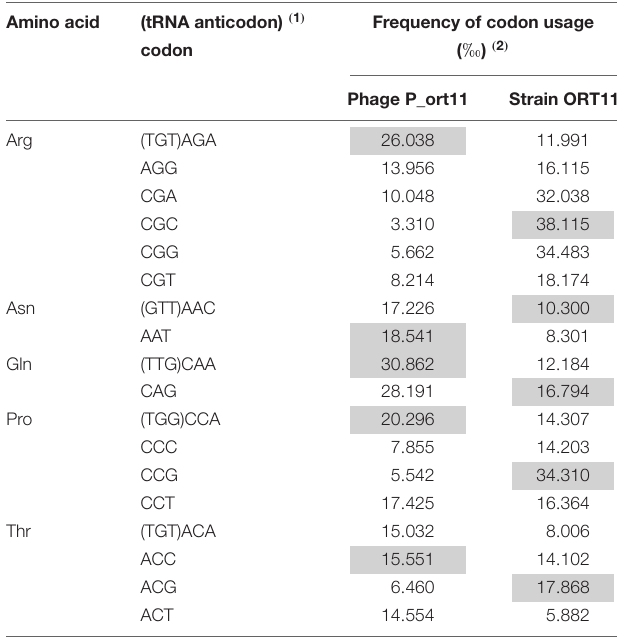
TABLE 2 | Codon usage of Sinorhizobium phage P_ort11 and bacterial host S. meliloti ORT11 for amino acids arginine, asparagine, glutamine, proline, and